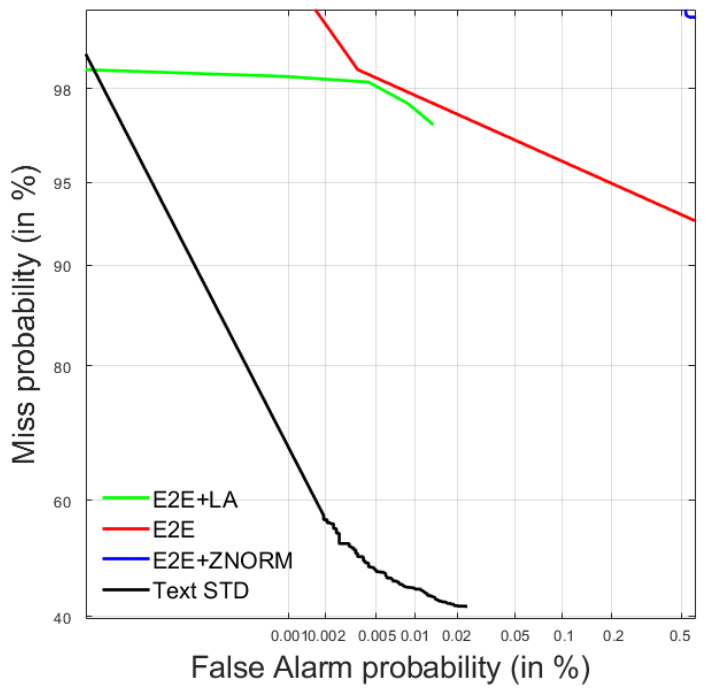
Figure 10. DET curves of the QbE STD systems and the text-based STD system for MAVIR test data.